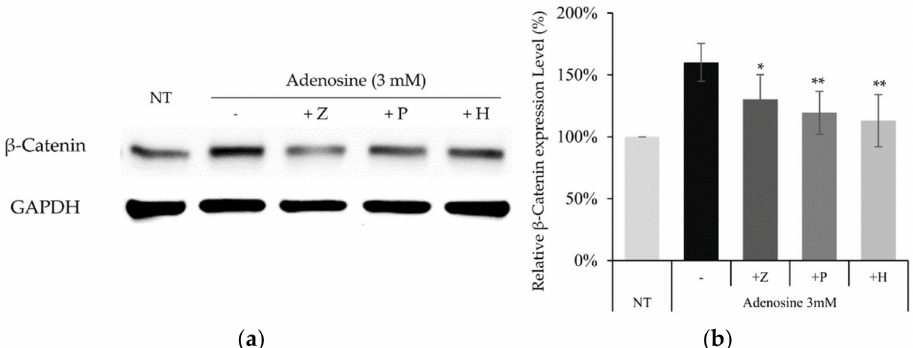
Figure 8. Activation of the Wnt/ β -catenin pathway by adenosine was abolished in the presence of adenosine receptor antagonists and PKA inhibitor. The cells were treated with adenosine in the presence of various inhibitors (ZM241385, PSB603, and H89) for 4 h and harvested. ( a ) Whole cell lysates were analyzed by immunoblotting to determine the levels of β -catenin. GAPDH was used as an internal control. ( b ) The expression level of β -catenin was evaluated. The data represent the means of five independent samples. Significantly different compared with the adenosine treated control. (* p < 0.05, ** p < 0.01); Adenosine (3 mM); Z: ZM241385 (20 µ M); P: PSB603 (10 µ M); H: H89 (10 µ